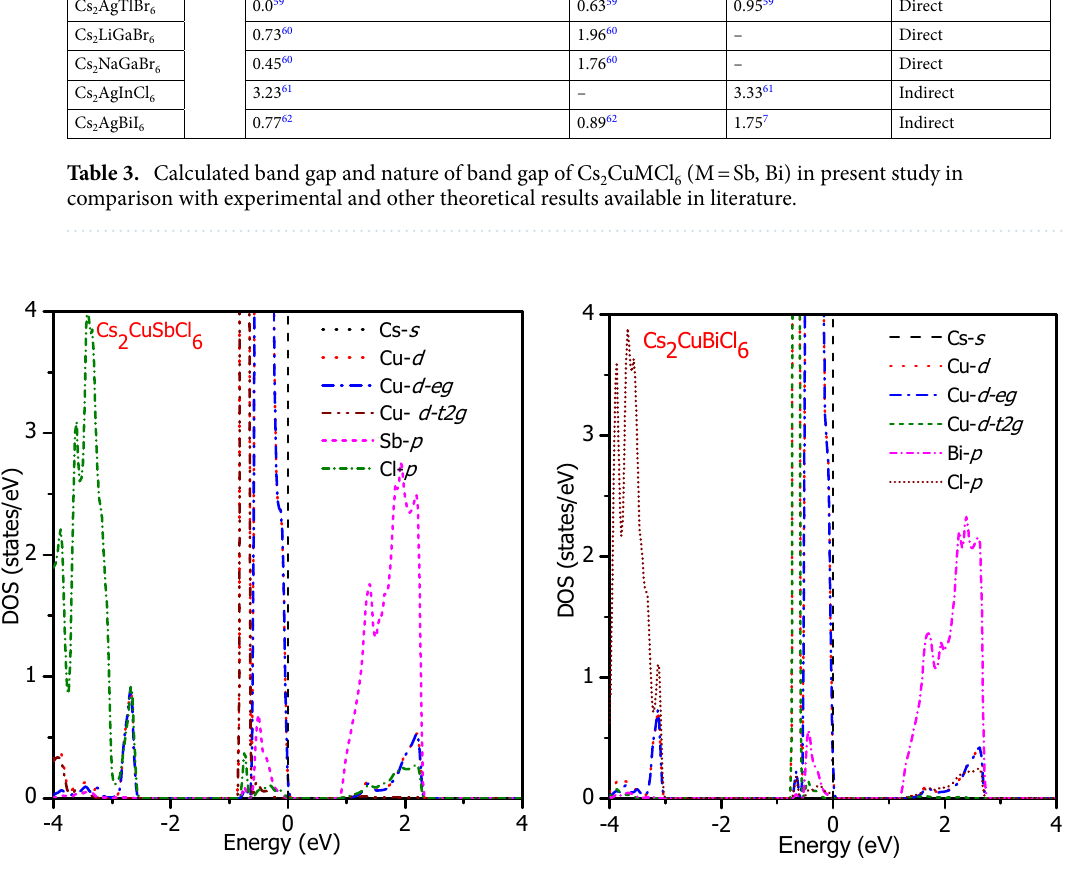
Figure 4. Partial density of states of Cs 2 CuMCl 6 (M = Sb, Bi) calculated by GGA + mBJ